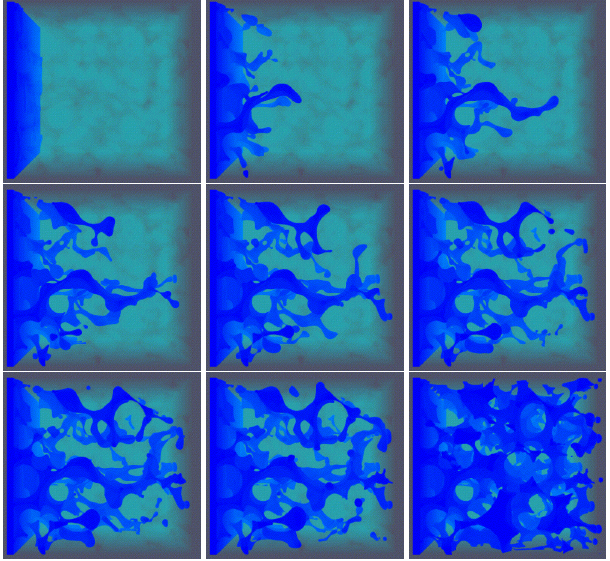
Figure 7. Snapshots of the drainage process simulation of Bentheimer sandstone. The non-wetting phase (oil) is shown in blue, and the rock is shown in transparent green. Saturation increases from left to right. The viscosity of invading fluid is 0.5 in a lattice unit and the viscosity of the defending fluid is 0.1 in a lattice